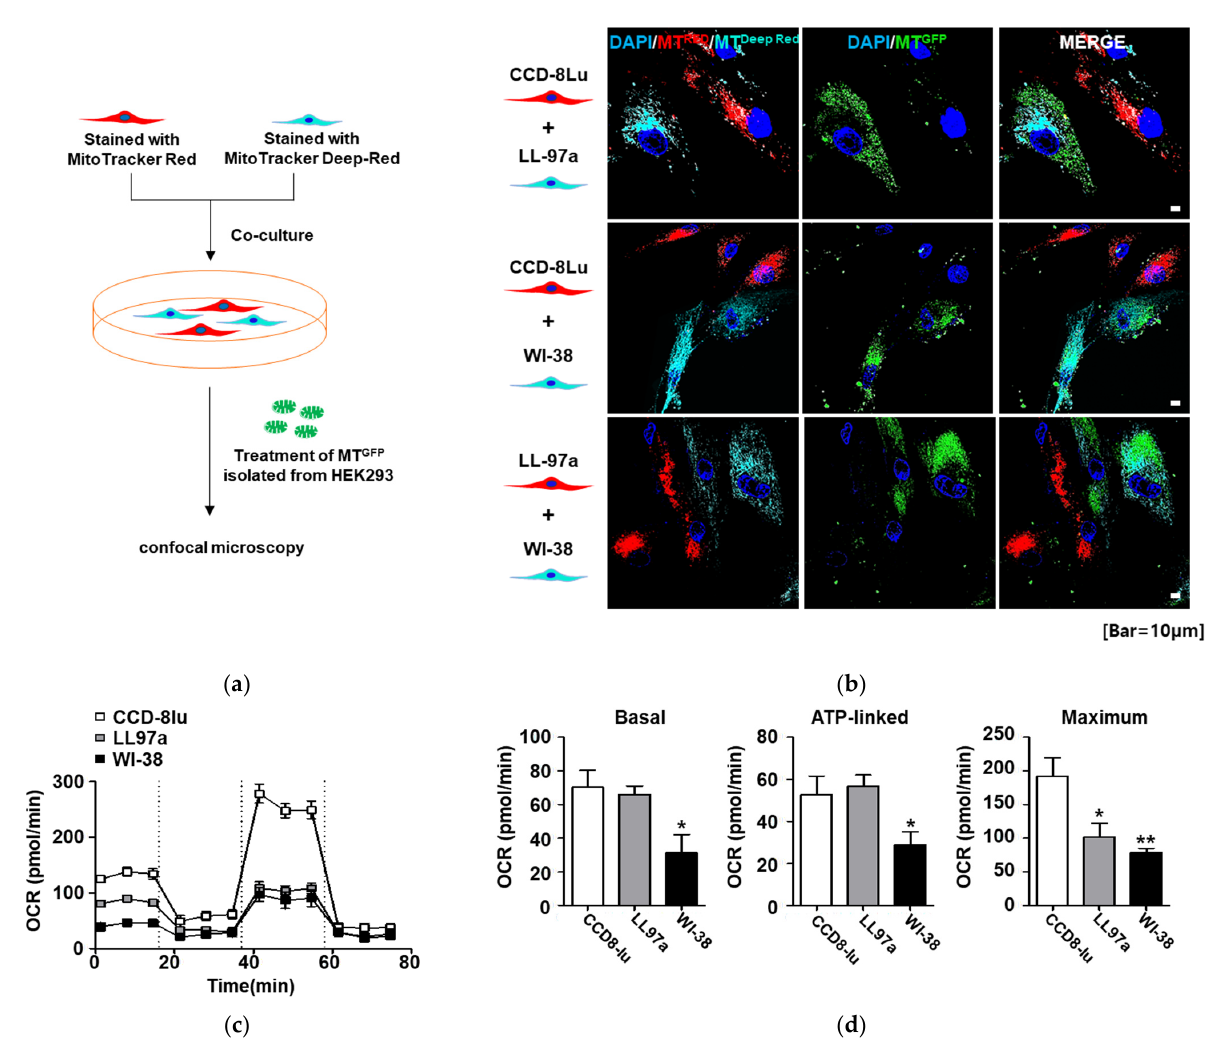
Figure 2. Selective transplantation of MTGFP into human lung fibroblasts in a coculture system. ( a ) Coculture model of three types of human lung fibroblast. Each fibroblast type was prestained with MitoTracker Red CMXRos or MitoTracker Deep-Red, as described in the Materials and Methods section. An equal density of each stained cell type was coplated, treated with MTGFP, and then imaged via a confocal microscope. ( b ) Selective transplantation of MTGFP in the coculture system. LL-97a or WI-38 fibroblasts prestained with MitoTracker Deep-Red took up much more MTGFP than was taken up by CCD-8Lu fibroblasts prelabeled with MitoTracker Red CMXRos (top and middle panels). Fluorescent images revealed that MTGFP were more abundant in WI-38 fibroblasts (deep red) than in LL97a fibroblasts (red) (low panel). Nuclear staining is shown in blue (DAPI). Scale bars: 10 μ m. ( c ) Bioenergetics profiles of three human lung fibroblast types. Representative OCRs were measured in CCD-8Lu, LL97a, and WI-38 fibroblasts. OCR values under basal conditions were recorded and analyzed. Subsequently, 1 µ M oligomycin, 1 µ M FCCP, and 0.5 µ M rotenone/antimycin A were injected into the medium (1 × 10 4 cells/well). Representative data are shown from three independent experiments. ( d ) Basal, ATP-linked, and maximal OCR levels. Basal OCR was measured before oligomycin treatment, and maximum OCR was measured after FCCP treatment and subtraction of the nonmitochondrial-derived OCR measurement following rotenone and antimycin A treatment. All OCR values were normalized using the cell mass measured with methylene blue (* p < 0.05 and ** p <